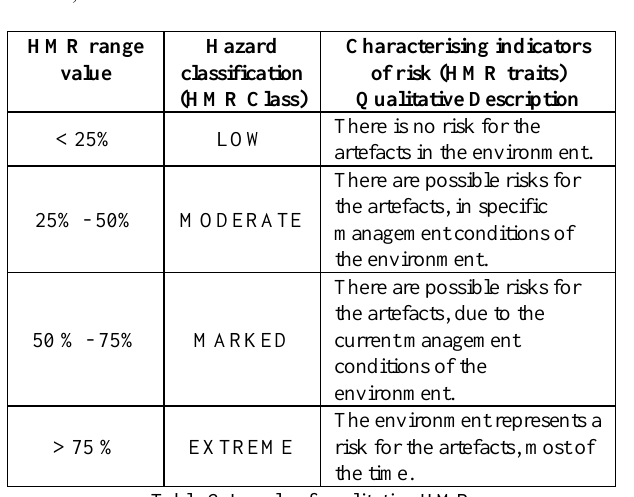
Table 2. Levels of qualitative HMR